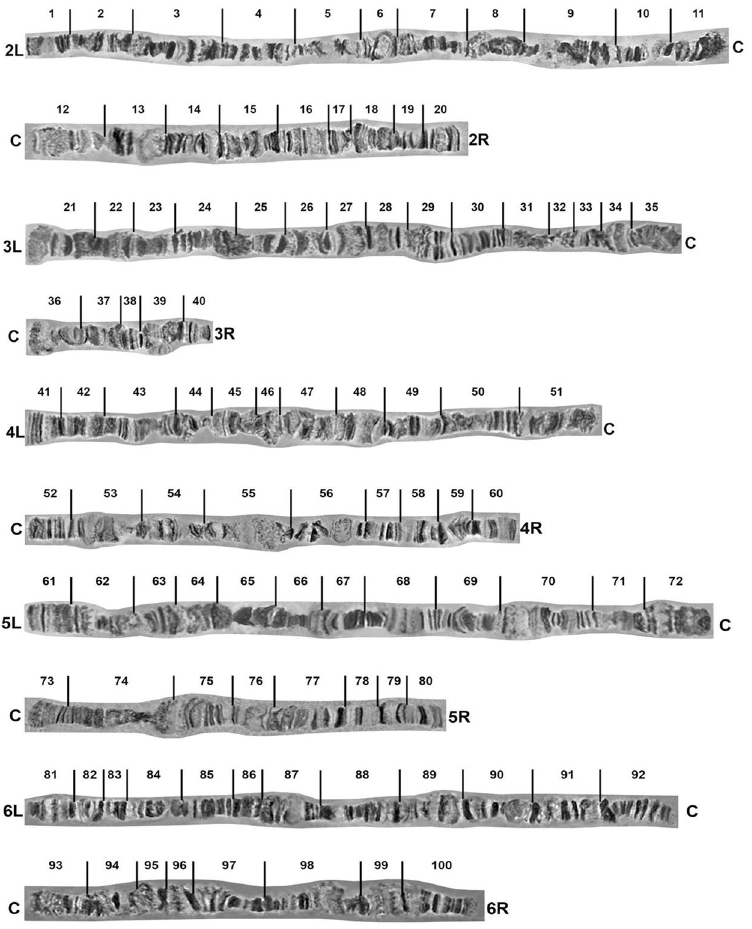
Figure 3. Photographic polytene chromosome map of Ceratitis fasciventris . C indicates the